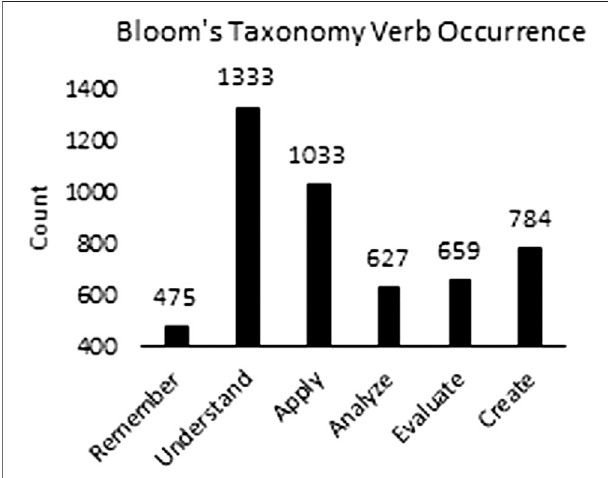
FIGURE 2 | Bloom ’ s Taxonomy Verb Frequency by Level for Reviewed Articles ( n (cid:1)